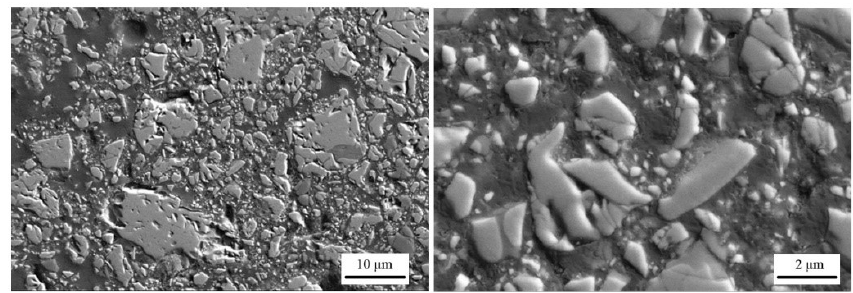
Figure 2. Microstructure of iron ore fines sample. Table 1. Chemical composition of the iron ore fines (wt%).